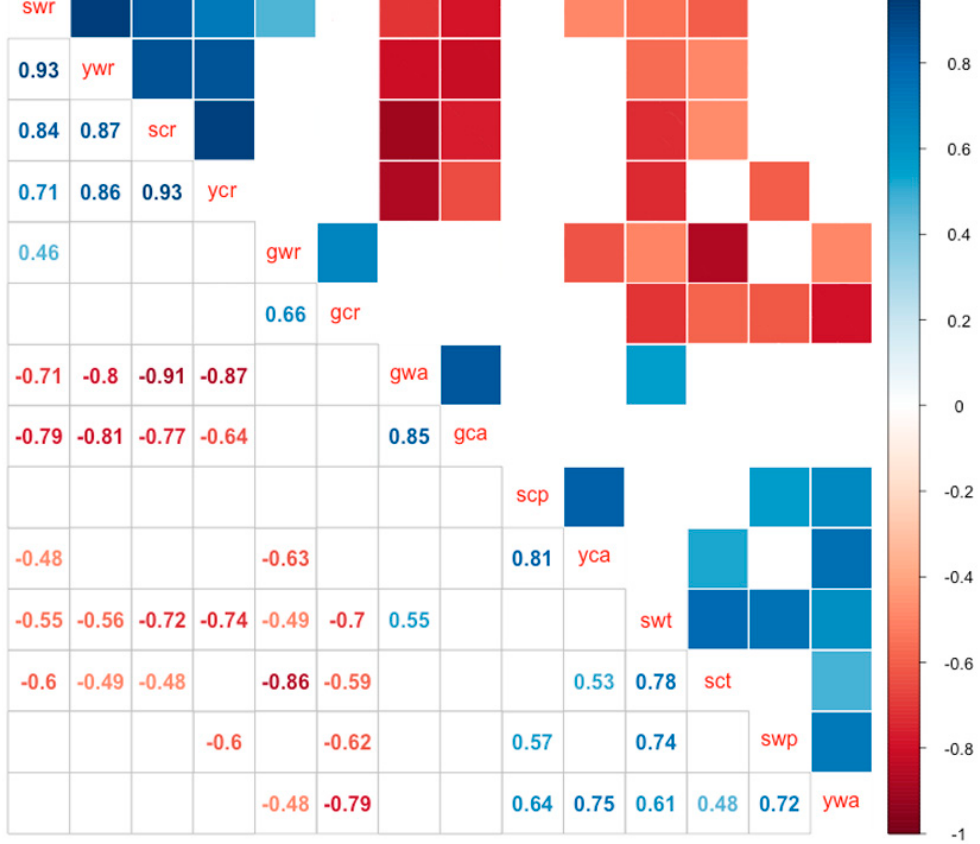
Figure 2. Pairwise correlation matrix of differentially-expressed miRNAs across tissue types, developmental stages, and wild and cultivated accessions. Pearson correlations between pairwise samples among all 14 experimental conditions were calculated by considering differentially-expressed miRNAs between each pairwise comparison as the distance between the two conditions. Blue boxes indicate positive correlation values (0 ≤ r ≤ 1; with 1 being complete positive correlation) and red boxes represent negative correlation values ( − 1 ≤ r ≤ 0, with − 1 being complete anti-correlation) between samples. Correlation with p -values >0.1 are not shown in this matrix. The order of the rows was determined by the hierarchical clustering of the correlation matrix. Closely-related conditions, such as conditions with the same type of tissues, were therefore grouped together. “gca” and “gcr”: aerial part and roots, respectively, of germinated seedlings of C08; “yca” and “ycr”: aerial part and roots, respectively, of young seedlings of C08; “sct”: trifoliates of C08 seedlings; “scp” and “scr”: Primary leaves and roots, respectively, of C08; “gwa” and “gwr”: aerial part and roots, respectively, of germinated seedlings of W05; “ywa” and “ywr”: Aerial part and roots, respectively, of young seedlings of W05; “swt”: Trifoliates of W05 seedlings; “swp” and “swr”: Primary leaves and roots, respectively, of W05.